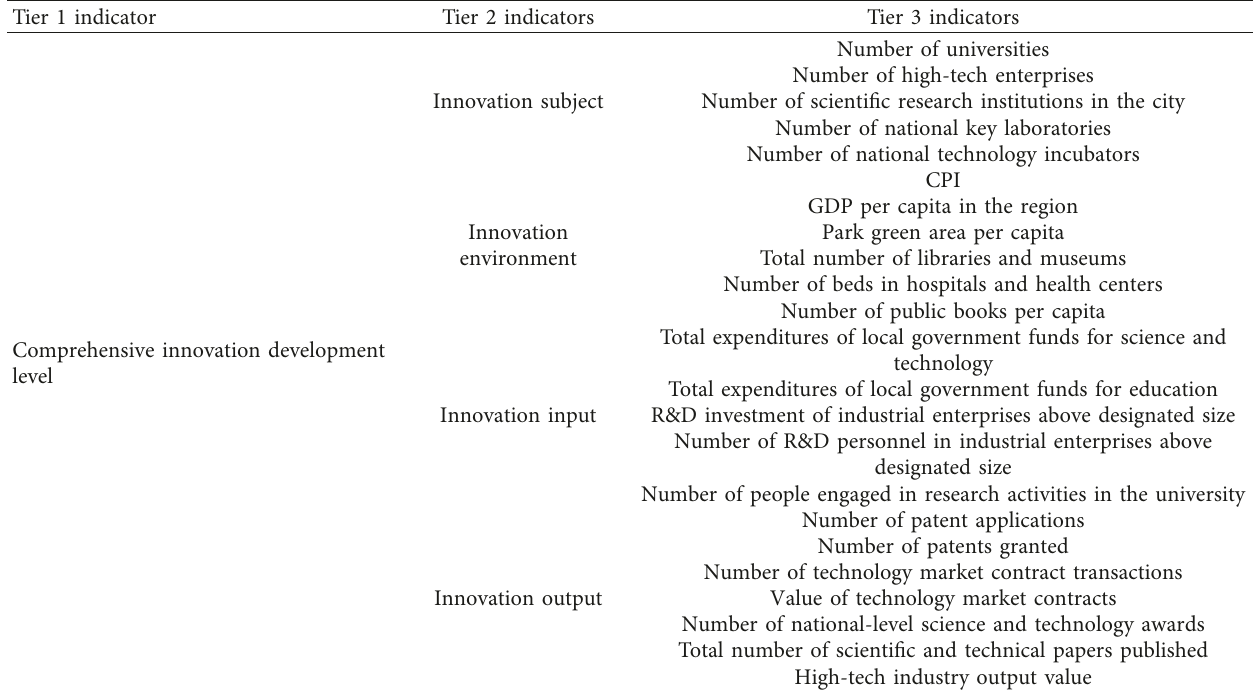
Table 2: Comprehensive innovation development level indicator system.